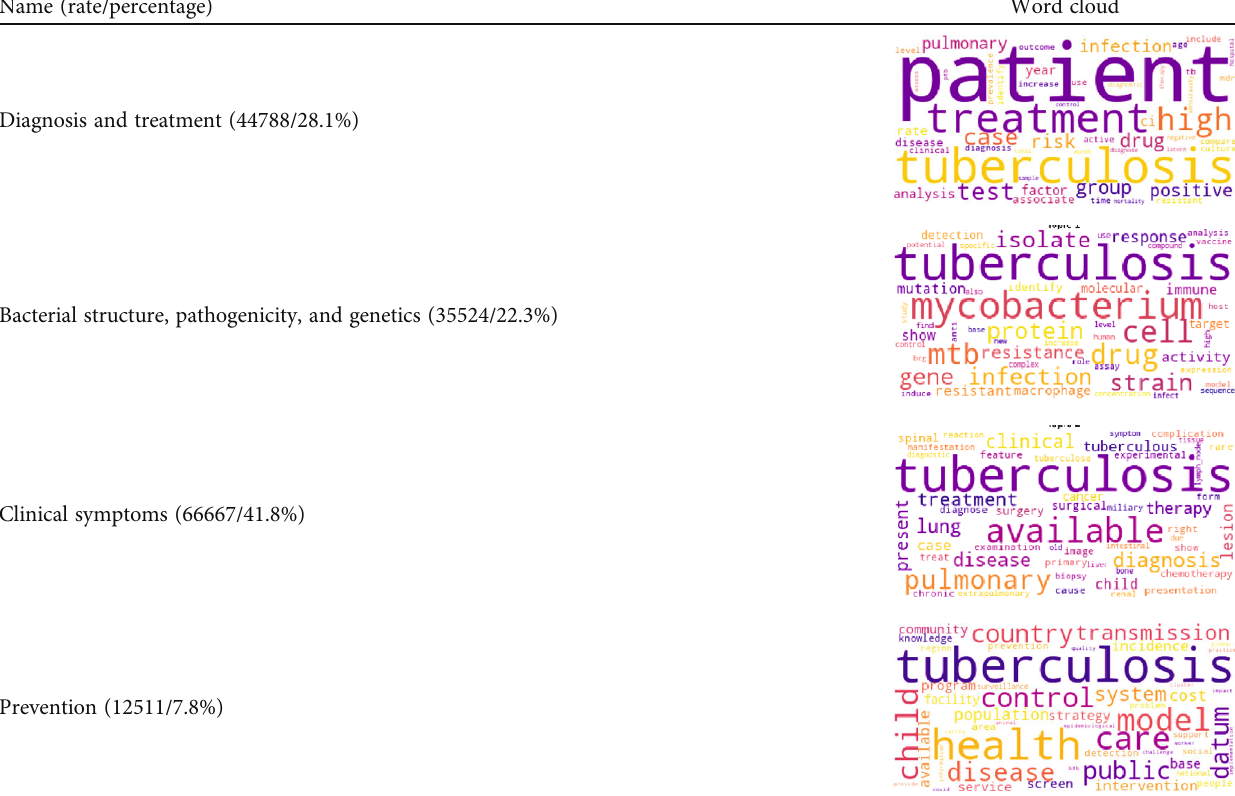
Table 1: Topics obtained from topic modeling of scienti fi c articles on tuberculosis.